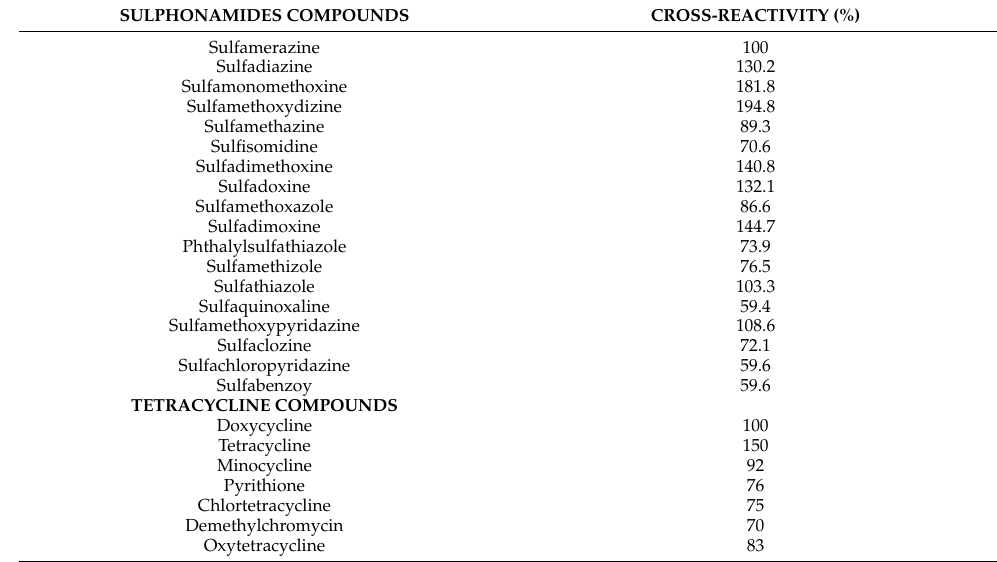
Table 3. The different compounds from sulphonamides and tetracycline and their corresponding